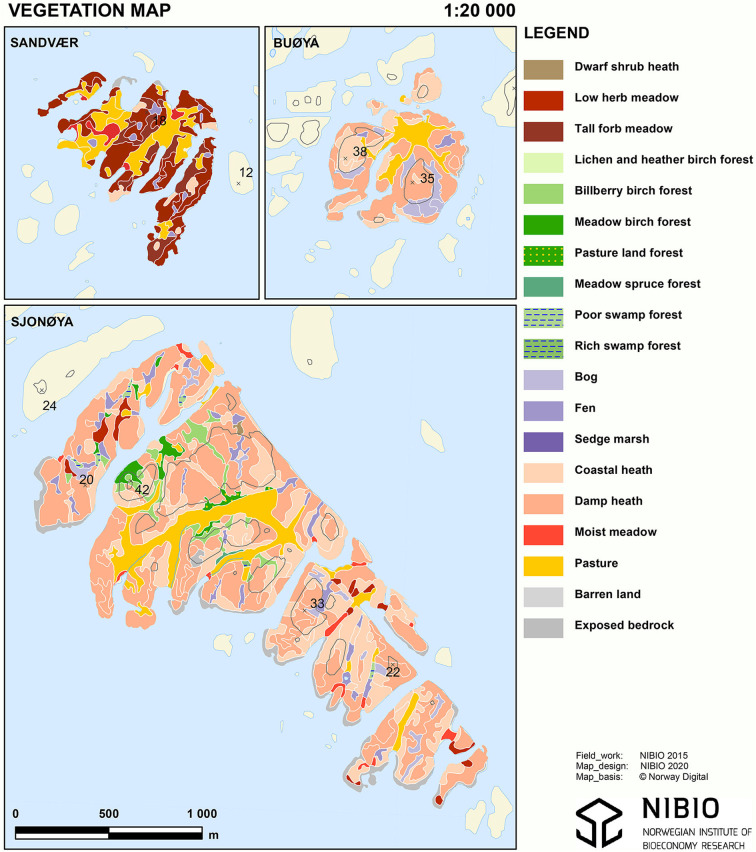
Vegetation maps of Sandvær, Sjonøya, and Buøya.